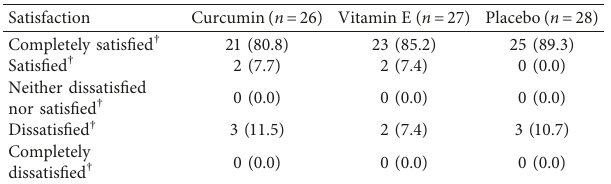
Table 5: Satisfaction with supplementation among the study groups.